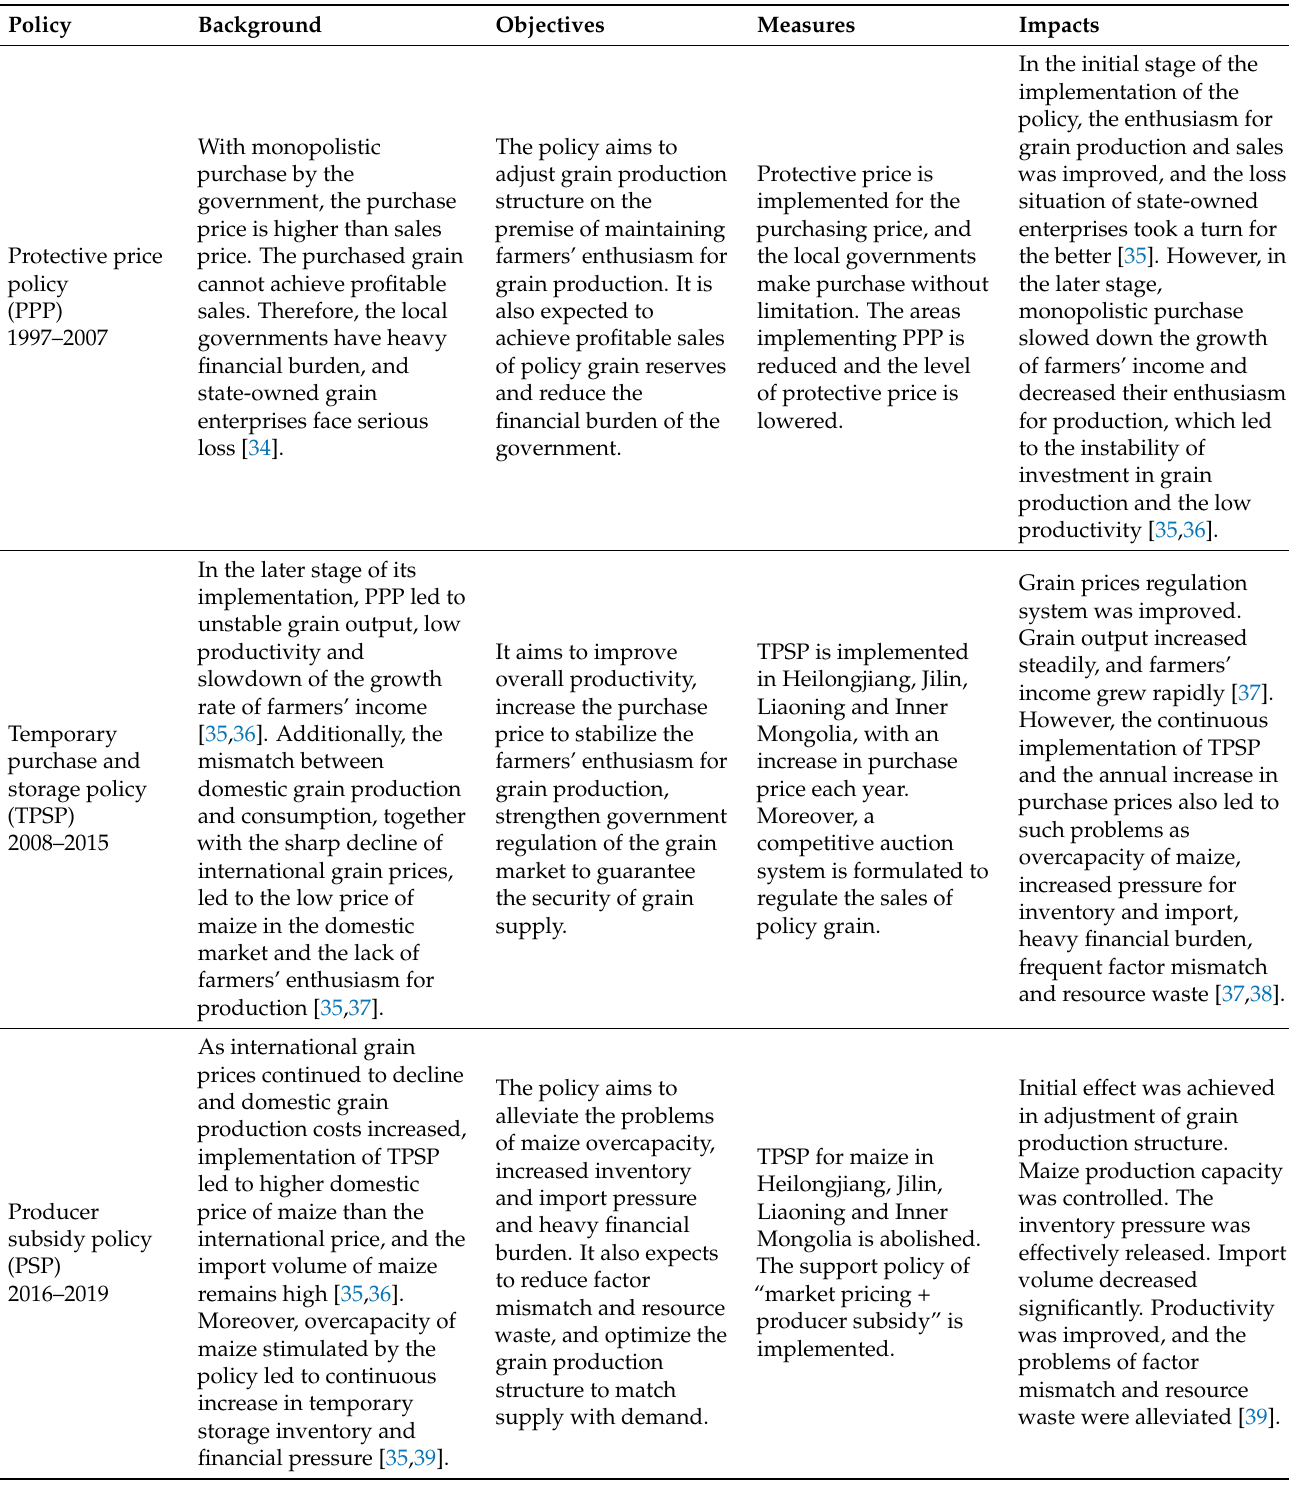
Table 1. Maize purchase and storage policies implemented in China from 1997 to